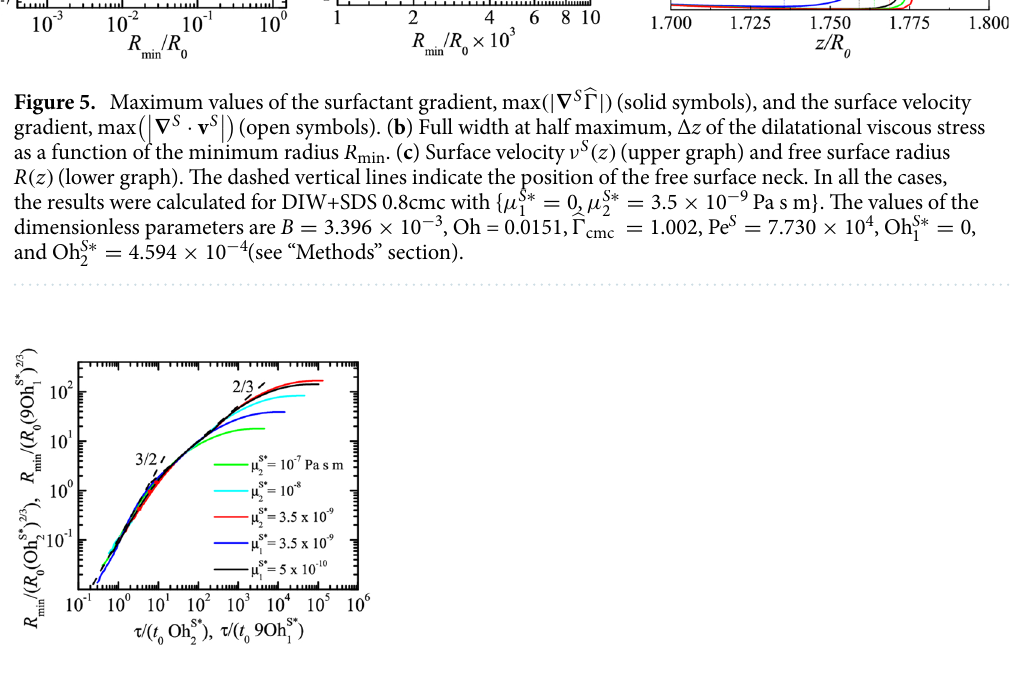
Figure 6. Dimensionless minimum radius R min / R 0 as a function of the dimensionless time to the breakup, τ/ t 0 , or the breakup of a pendant drop of DIW+SDS 0.8cmc. The labels indicate the values of the non-zero shear/dilatational viscosity in each case. The results were calculated for B = 3.396 × 10 − 3 , Oh = 0.01510, Ŵ cmc = 1.0016 , and Pe S = 7.73 × 10 4 (see “Methods” (cid:31)